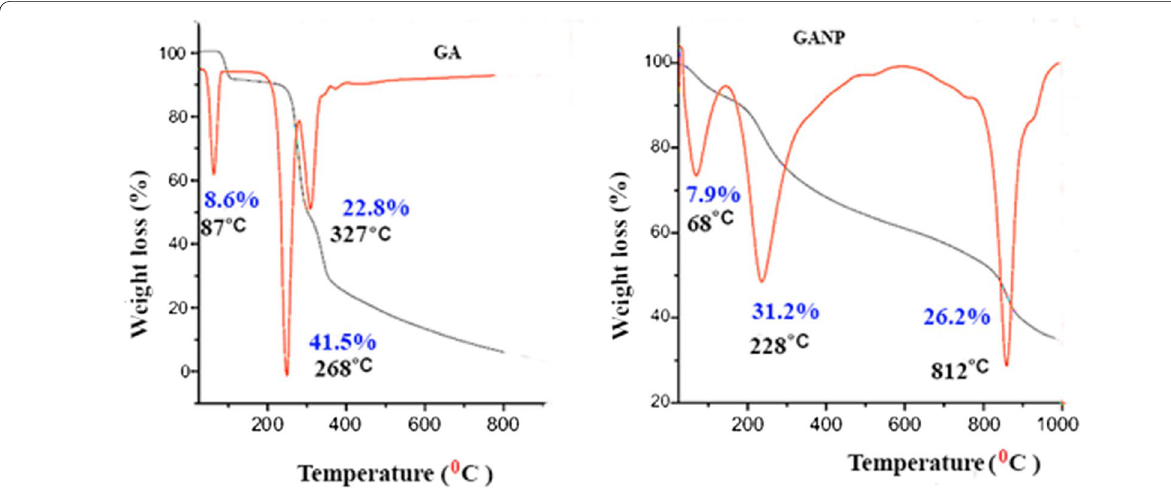
Fig. 5 TGA graph of GA and GANP